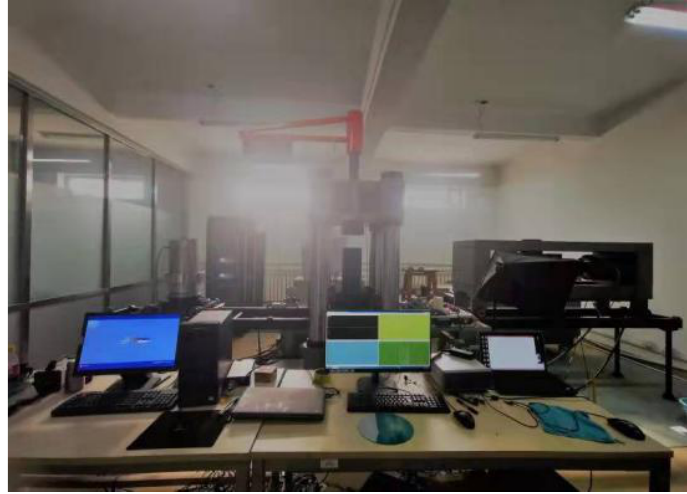
Figure 2. Uniaxial compression test system.